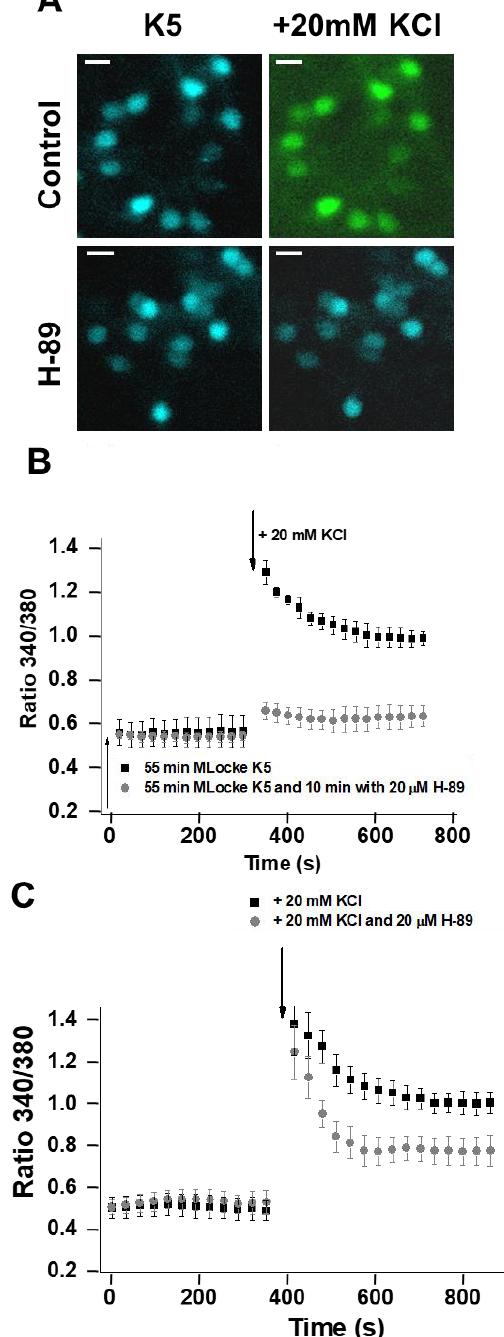
Figure 6. H-89 blocks the rise in [Ca 2+ ] i of CGNs in response to the increase in extracellular potassium. Mature CGNs in culture were loaded with Fura-2, as indicated in the Materials and Methods section, and then changed to MLocke’s K5 buffer (37 ◦ C) and incubated for 1 h in a 5% CO 2 culture chamber and thereafter treated as indicated below. ( A ) Representative pseudocolor images of the same fields of selected CGN plates after 1 h in low-potassium MLocke’s K5 before (left) and 10 min after the addition of a pulse of 20 mM KCl to the extracellular medium (right) for a control and after a 15 min incubation with 20 µ M of the PKA inhibitor H-89. Pseudocolor scale for 340/380 ratio values: light blue, 0.5–0.6; green, 1.0–1.1. Scale bar = 10 µ m. ( B ) Population averages of 340/380 ratio measurements in neuronal somas before and after the addition of 20 mM KCl at the time indicated with a black arrow.